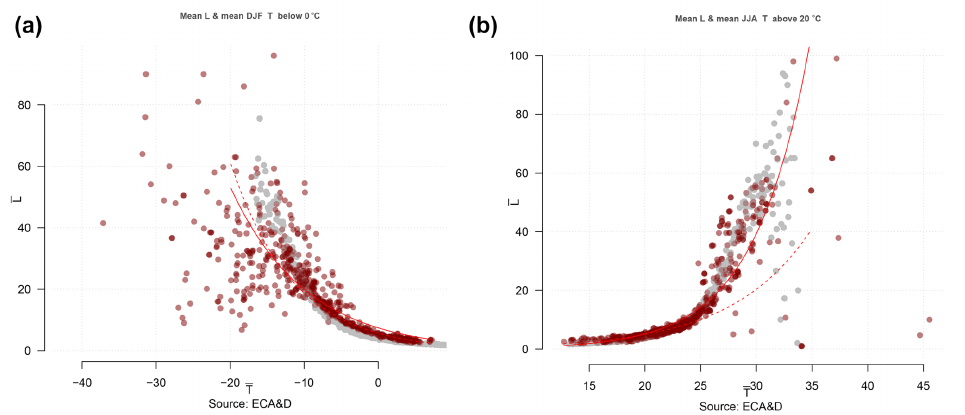
Figure 1. Comparison between winter (a) and summer (b) mean daily maximum temperature ( x axis) and the mean duration of cold (a) or warm (b) spells in Europe based on ECA&D. Grey dots show comparable results to a set of Monte Carlo simulations carried out with Gaussian red noise, and red lines indicate best fits based on GLM with a negative binomial (dashed lines) and a Poisson-type GLM (solid lines). The GLMs fit were statistical significant at the 1% level for both cases (see